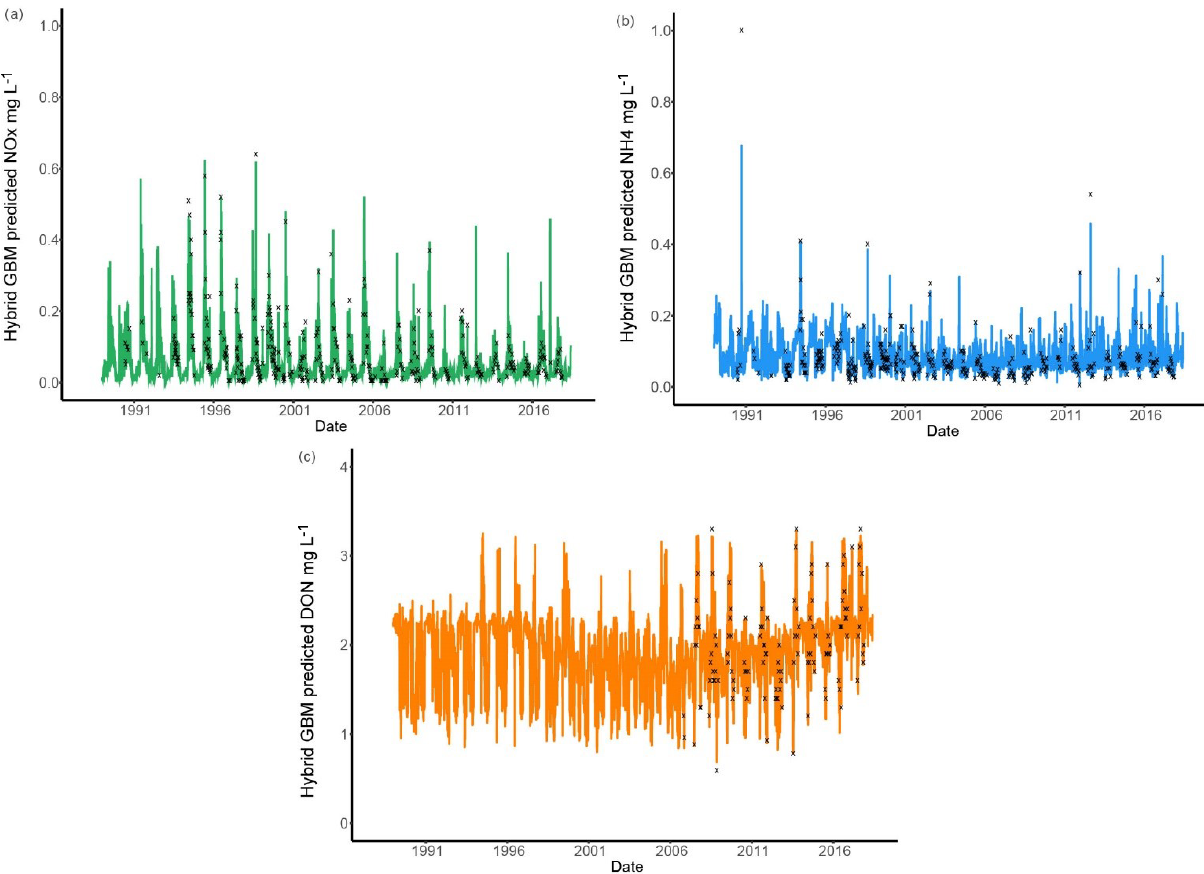
Figure 7. Generated daily DON, NO x and NH 4 by the hybrid GBM for Ellen Brook.